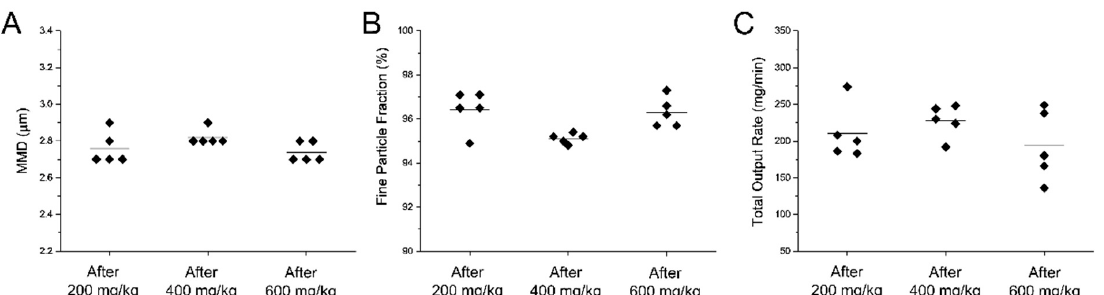
Figure 5. Individual ( A ) mass median diameter (MMD), ( B ) fine particle fraction and ( C ) total output rate values determined at different time-points during the nebulization of a 600 mg/kg dose of Poractant alfa (calculated for a birth weight of 1750 g). All parameters were determined after the nebulization of the first 200 mg/kg, after nebulization of 400 mg/kg and after nebulization of 600 mg/kg. The black horizontal line represents the mean of five repetitions.